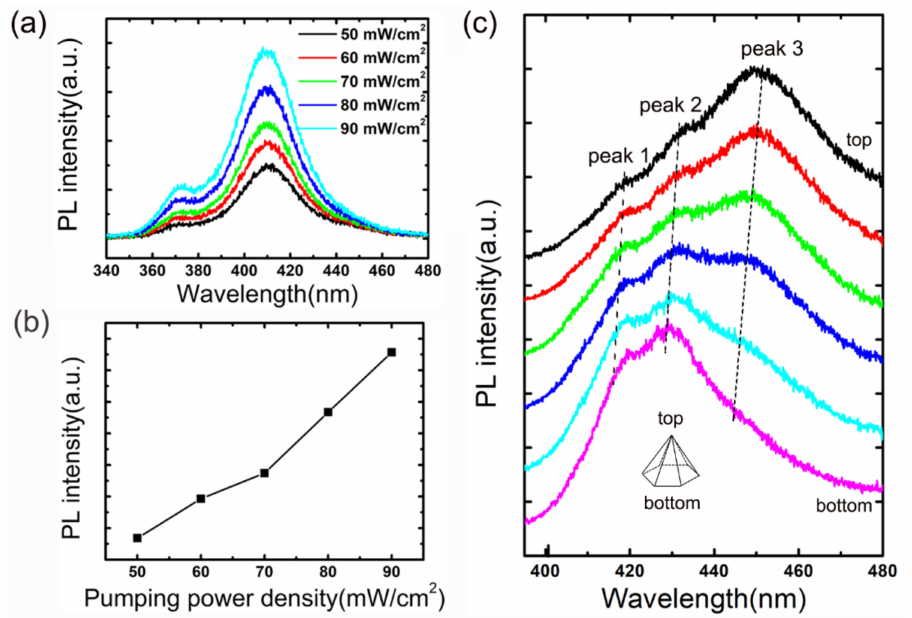
Figure 3. Macro-scale PL spectra ( a ), the influence of excitation power density on the PL intensity of the µ -LED array ( b ), and spatially resolved µ -PL spectra of a single µ -LED pyramid ( c